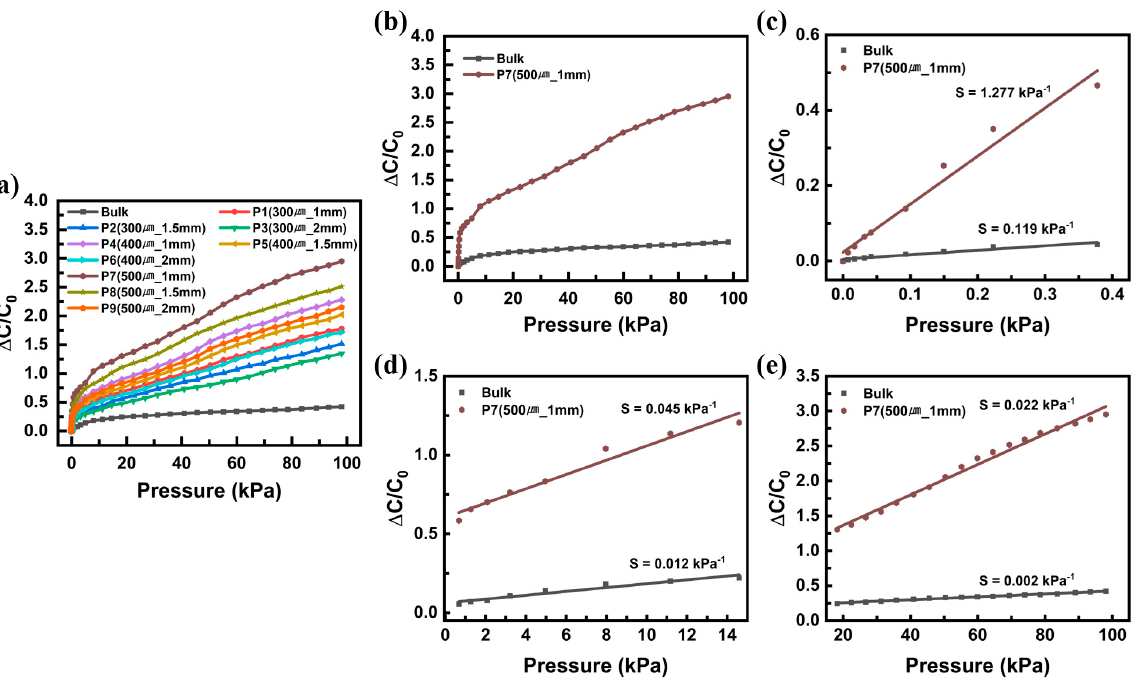
Figure 4. Pressure − response curves of pressure sensors for various structures ( a ) with pore size 300 − 500 μ m (increased by 100 μ m), distance 1 − 2 mm (increased by 0.5 mm). ( b ) Comparison of the pressure sensors’ performance with alignment airgap and with bulk Ecoflex dielectric layer. ( c – e ) Variation of the relative difference in capacitance with applied pressure ranges from 1 − 100 kPa.